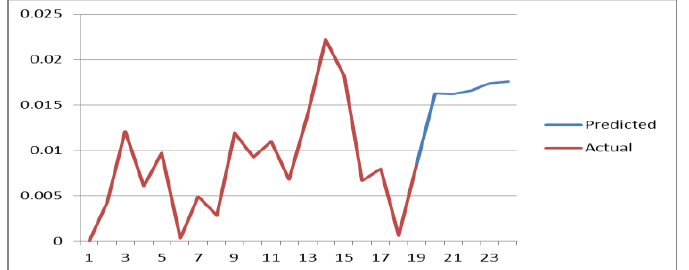
Figure.10. Short-term Prediction of GARCH based NNAR